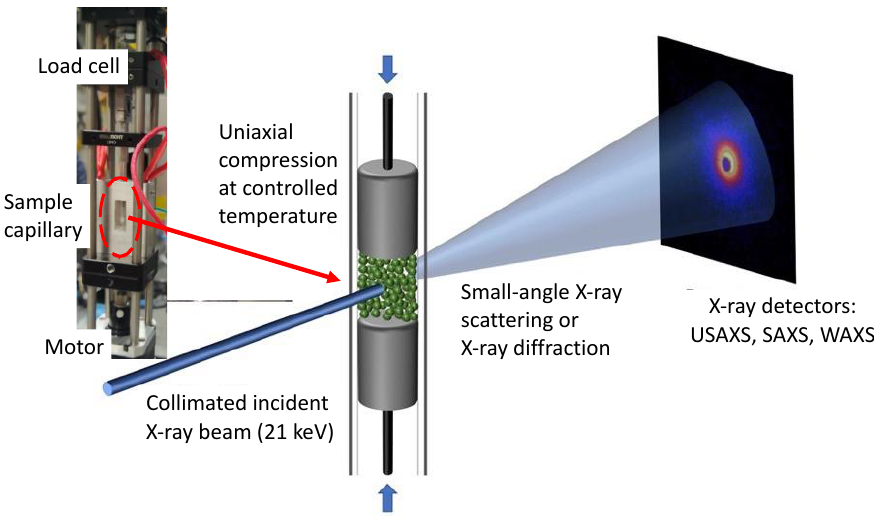
Figure 2. Schematic of CSP stage geometry for in situ USAXS/SAXS/WAXS measurements. Inset shows photograph of actual stage in operation.